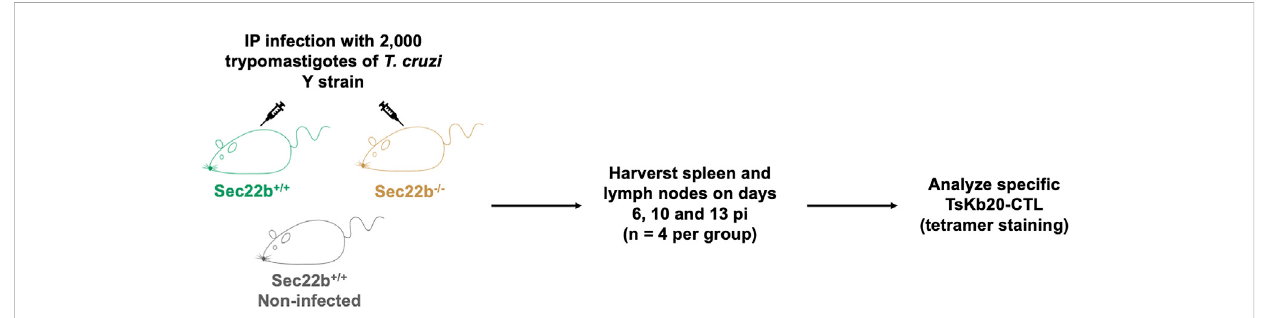
FIGURE 1 Experimental scheme. Male Sec22b +/+ and Sec22b − / − mice were IP infected with 2,000 trypomastigotes of the T. cruzi Y strain. As controls, Sec22b +/+ mice were left uninfected. At days 6, 10 and 13 post infection four mice per group were euthanized and spleen and lymph nodes were harvested to analyze the speci fi c TsKb20-CD8 + T cell response by fl ow cytometry using tetramer